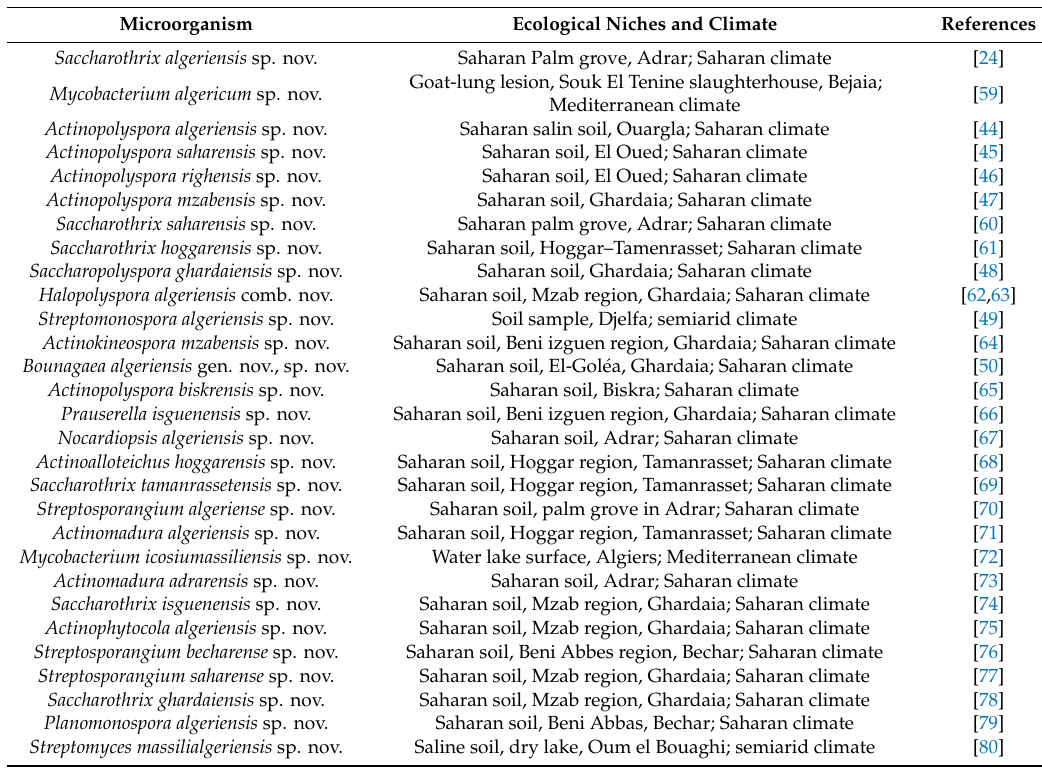
Table 1. List of novelly discovered rare actinobacteria species isolated from di ff erent ecosystems in Algeria since